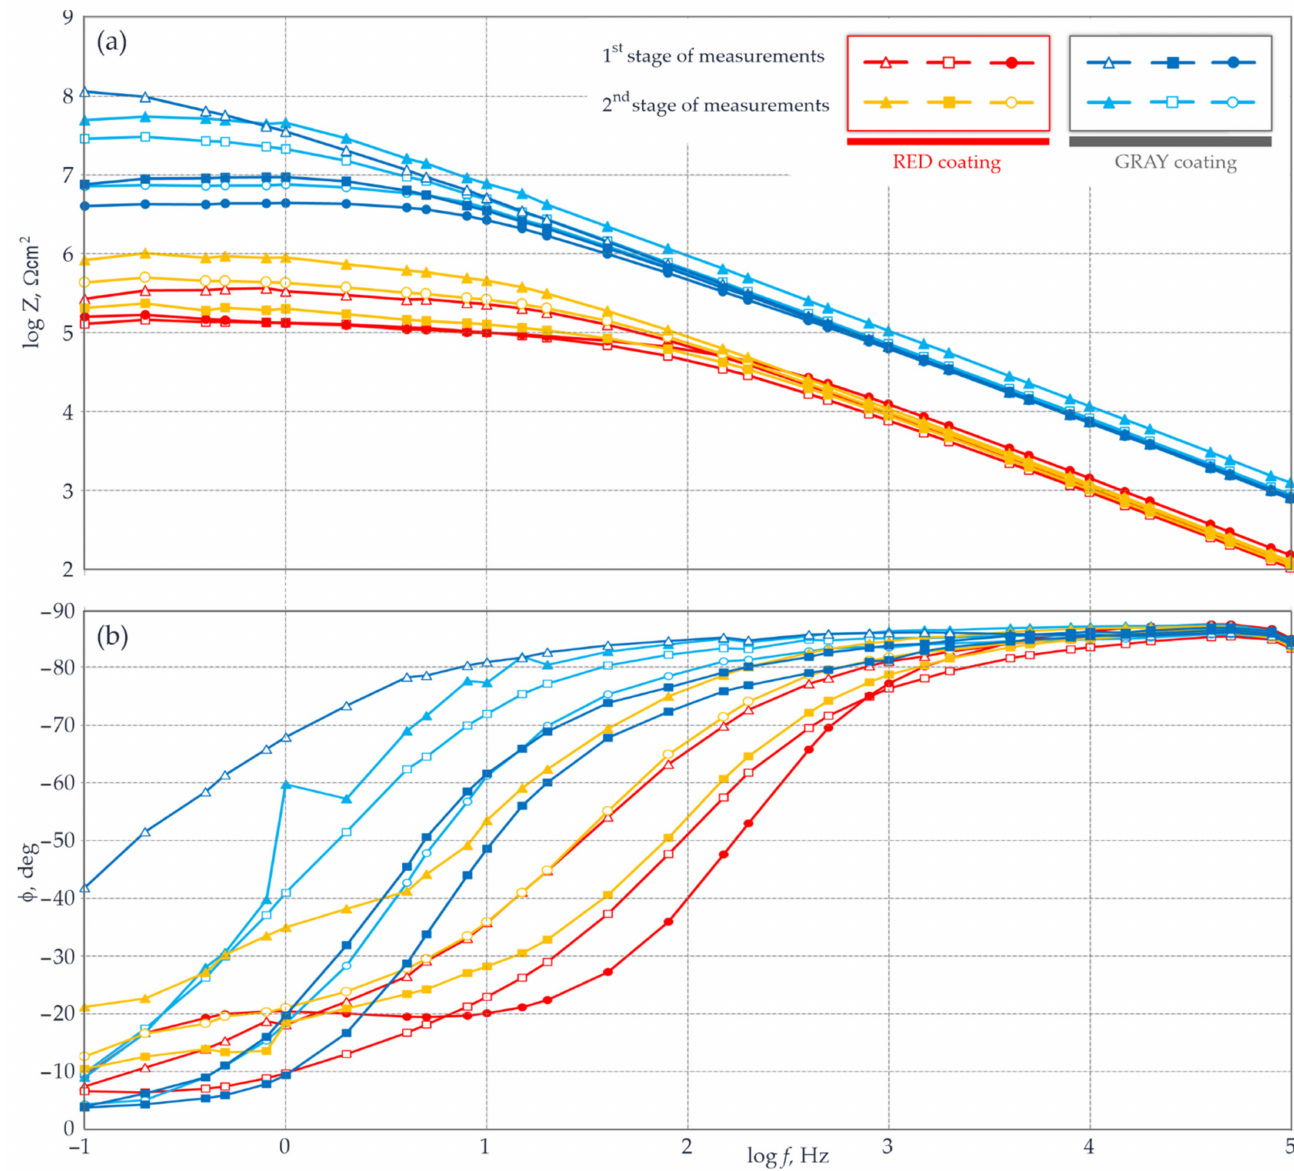
Figure 8. Measured impedance for two small sheets with a thinner red coating and a thicker grey coating: ( a ) the Bode plot Z(f); ( b ) the Bode plot ϕ (f)—described in the